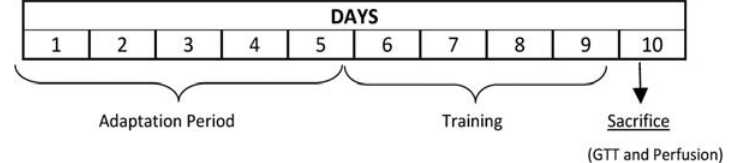
Figure 1. Experimental design. GTT: glucose tolerance